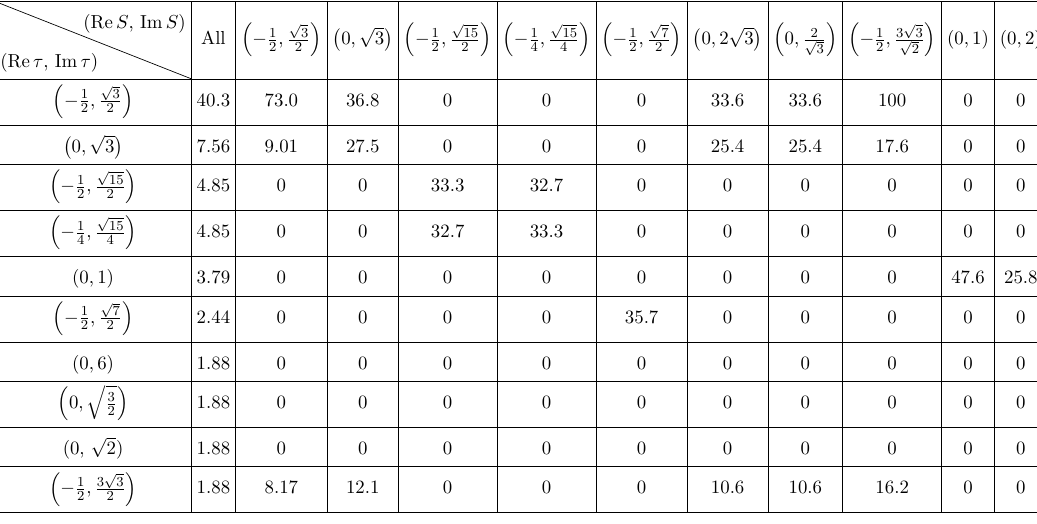
Table 10 . Probabilities of the stable vacua as functions of (Re (cid:28); Im (cid:28) ) and (Re S; Im S ) in the descending order of the probability with respect to (Re (cid:28); Im (cid:28) ). Here, we list the probability for N max = 1000 and the column in \All" corresponds to the probability of table 3. (cid:13)ux